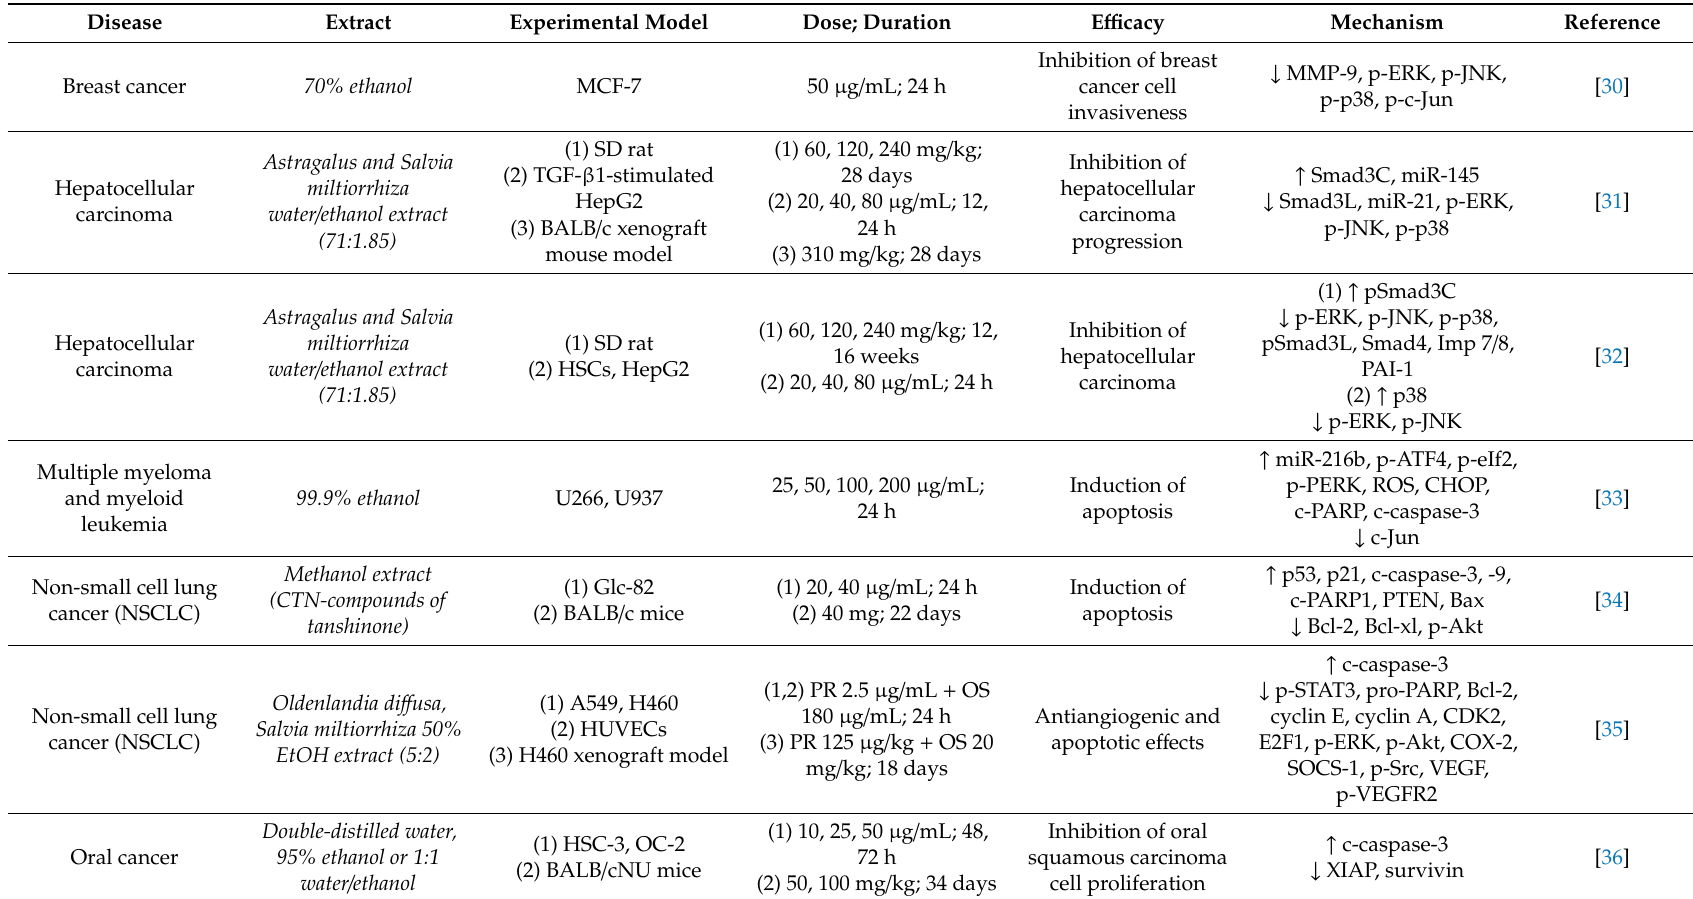
Table 1. Cancer and S.